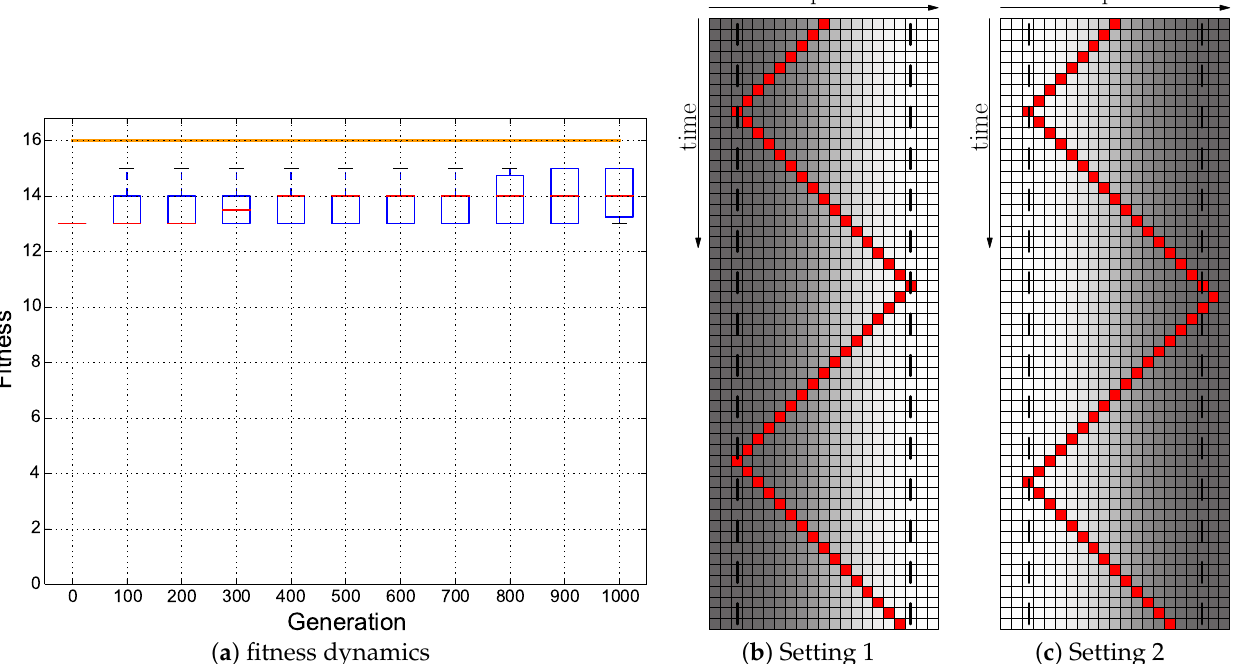
Figure 13. Evolutionary results of the Switch fitness regime starting with the hand-coded ANN (Figure 5a): fitness = F ( 1,0,0 ) ; the minimum of both evaluations was used as the fitness value for each genome. ( a ) Fitness dynamics of the evolutionary population. The horizontal orange line indicates the maximum fitness achievable by a reactive Wankelmut controller. ( b , c ) Trajectory of the best performing genome in both environmental